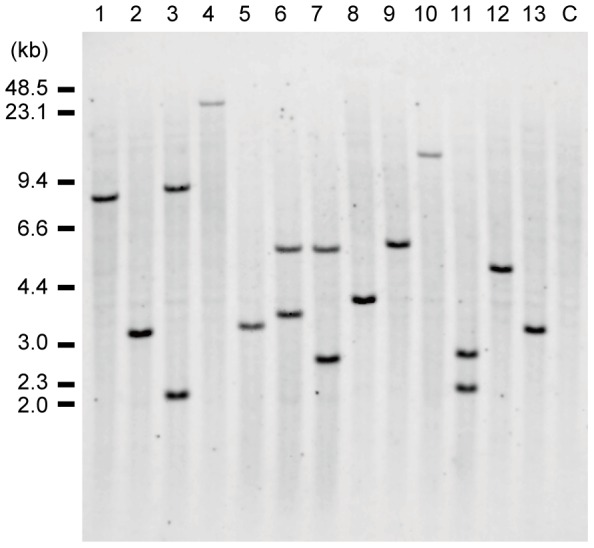
Genomic Southern blot analysis of T0 plants.Genomic DNAs of 13 independent T0 plants (lines #1-13) and a non-transformed plant (C) were analyzed by EcoRI digestion and detection of the sGFP sequence. The size of several bands is shorter than the minimal length expected from the intact T-DNA sequence (3.0 kb; Figure 2A), suggesting that the T-DNA sequence had undergone truncation and/or rearrangement.